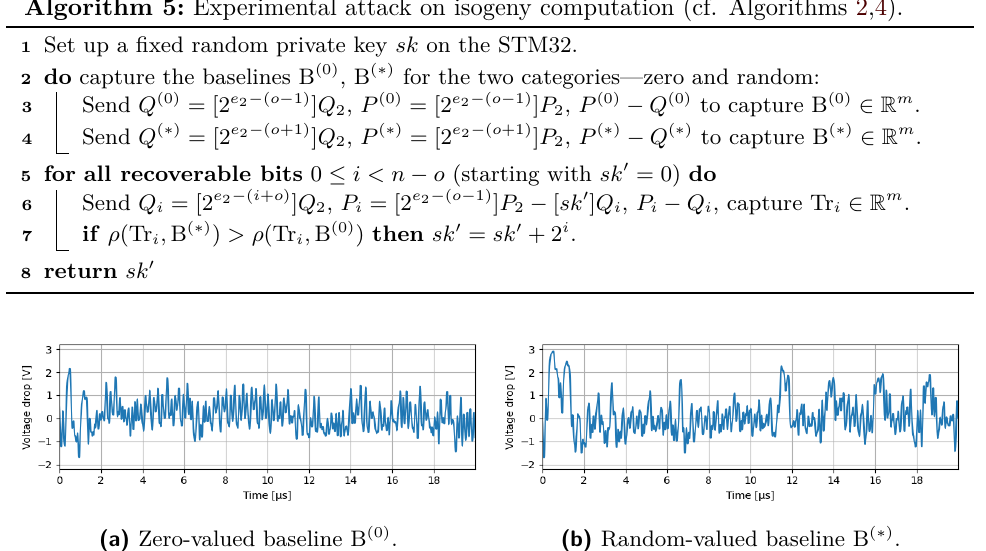
multiplication pro- p 2